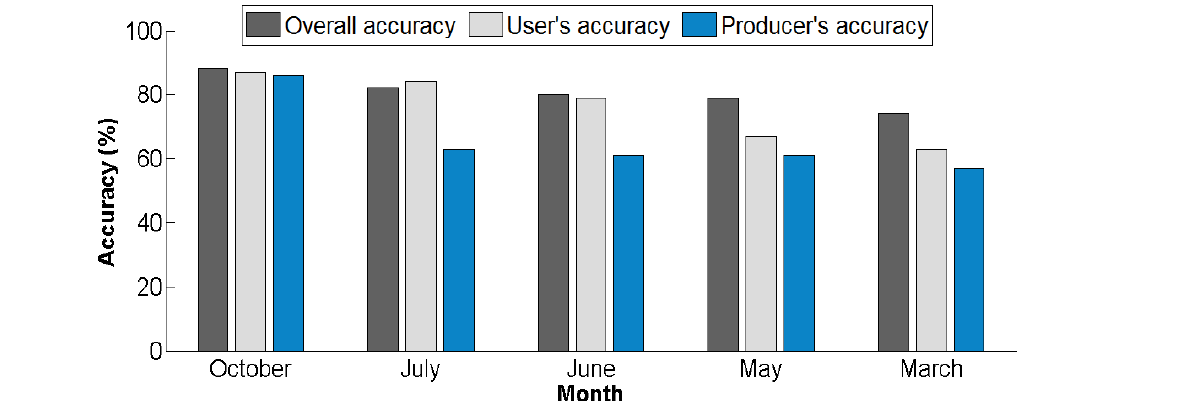
Figure 2. Overall, user’s and producer’s accuracies of the mono-temporal classifications of 2011 derived from adjusted error matrix. User’s and producer’s accuracies are averages of the class-wise